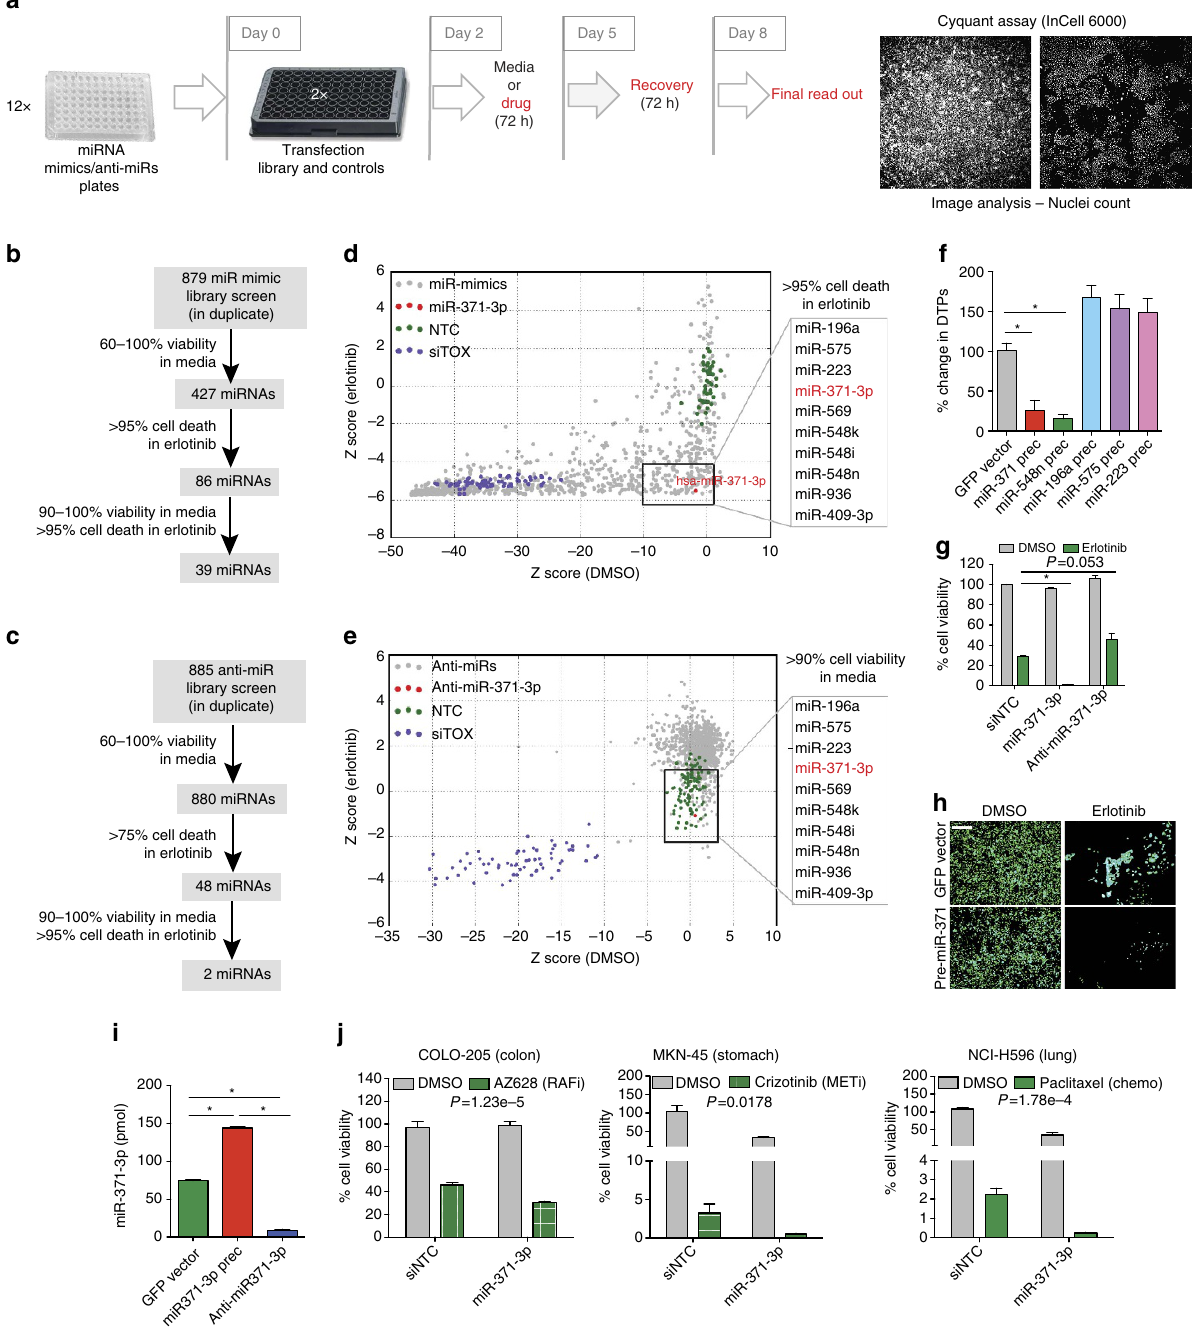
Figure 1 | Functional screening identifies miR-371-3p as a regulator of DTPs. ( a ) miRNA mimic or inhibitor screening strategy. ( b ) miR-mimic library and ( c ) anti-miR library screen summary. ( d ) miR mimic screen data and ( e ) anti-miR screen data plotted as z scores of miRNAs in erlotinib ( y axis) versus DMSO ( x axis). ( f ) DTP count in miRNA mimic-expressing PC9 cells. ( g ) Effects of miR-371-3p, anti-miR371-3p and controls on DTPs. ( h ) Representative fluorescence images of GFP control or pre-miR-371-expressing parental cells and DTPs. Scale bar, 20 m m ( i ) Expression of miR-371-3p in a pre-miR-371-or anti-miR-371-expressing PC9 line validated by absolute quantitative PCR. ( j ) miR-371-3p overexpression reduces DTPs in COLO-205, MKN-45 and NCI-H596 cells upon drug treatment. All experiments were performed in triplicate and data are representative of at least two independent experiments. Data are represented as mean ± s.e.m. For f , g and i , * P o 0.05, Student’s t -test. For j , P represents interaction P